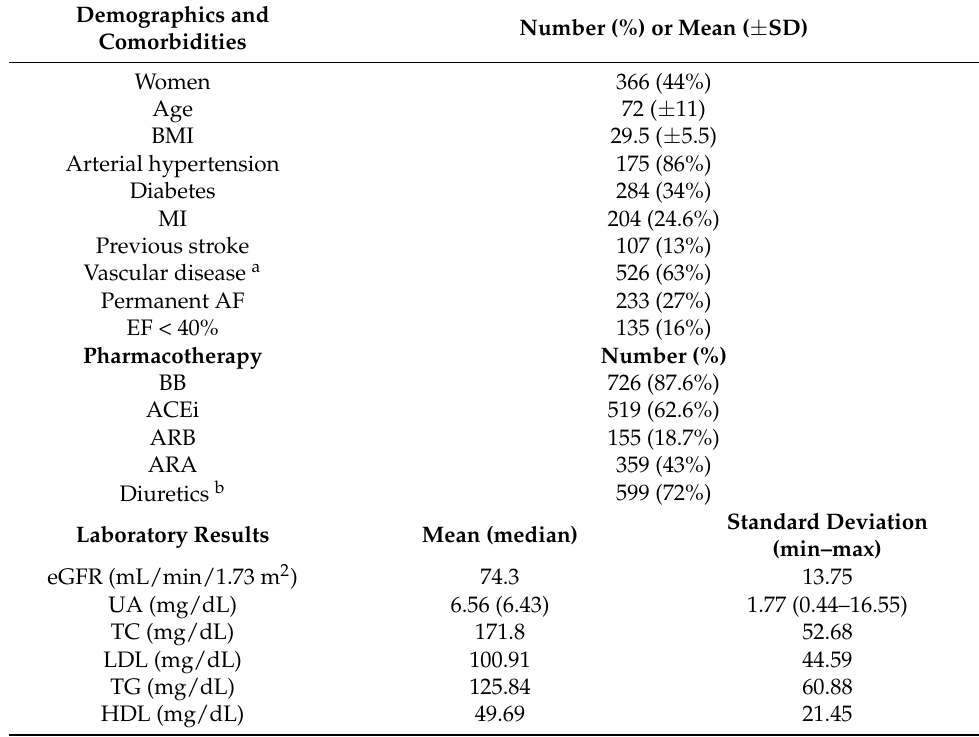
Table 1. General characteristics of study patients with atrial fibrillation ( n = 829). Demographics and